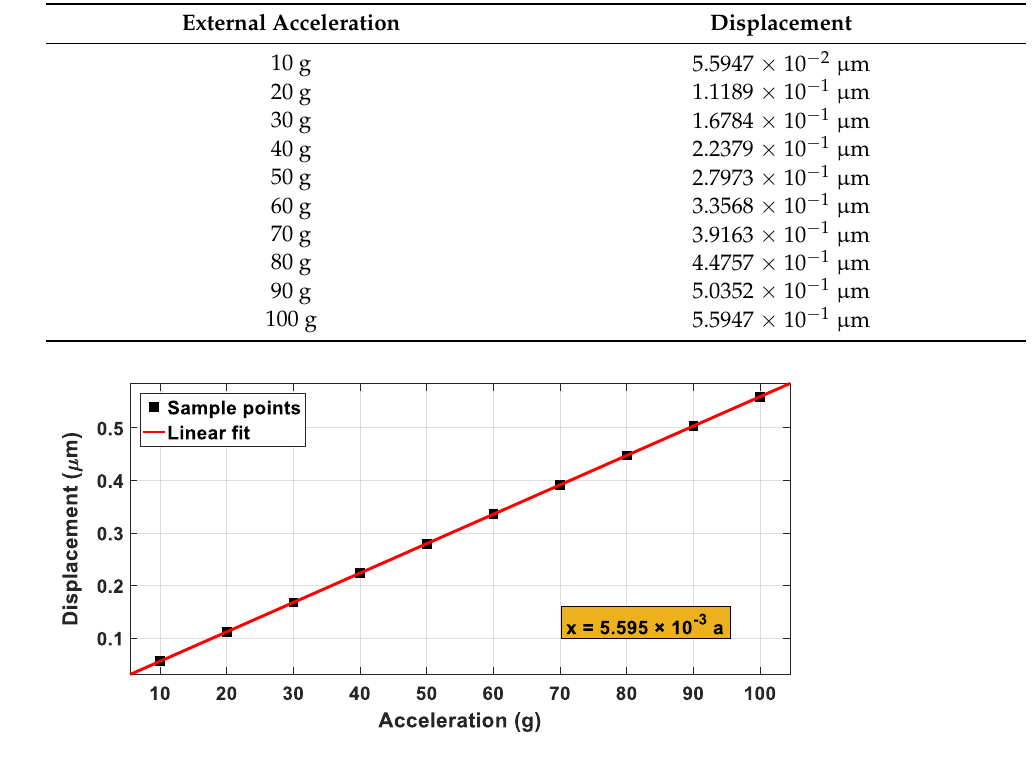
Figure 12. Relationship between displacement and acceleration.